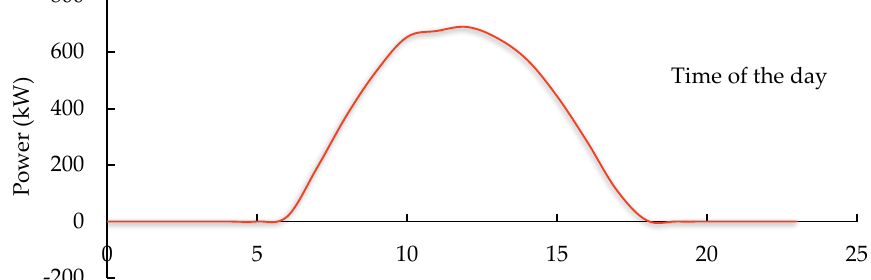
Figure 14. Average generation values for the photovoltaic solar power plant for simulation config- uration.